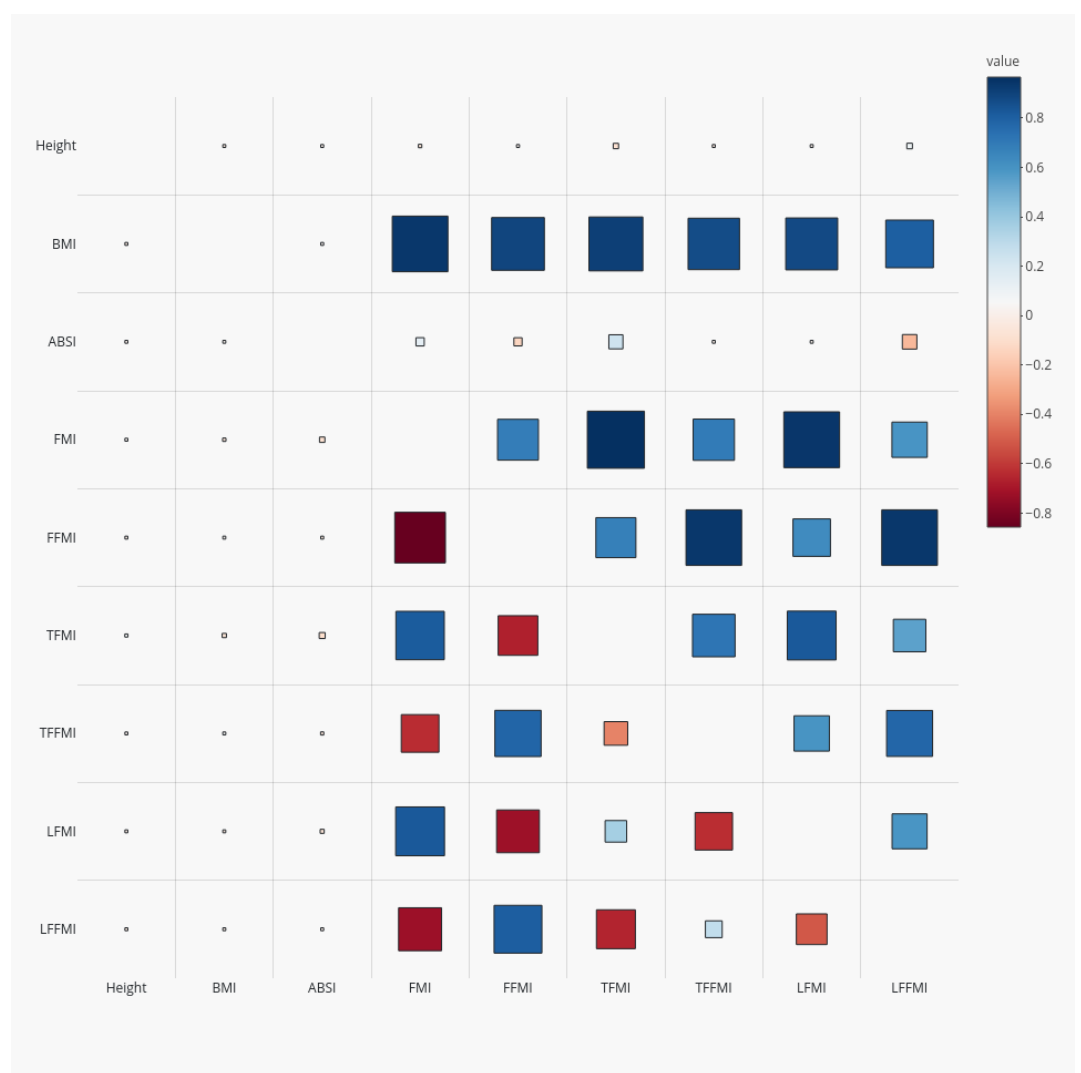
Figure 1. Correlation coefficients for anthropometrics and DEXA-derived body composition indices (Z scores relative to age- and sex-specific means) among NHANES 1999–2006 adults. Red squares denote positive correlations and blue negative ones; larger size indicates larger correlation magnitude. The upper right half of the correlation matrix shows correlations of the unadjusted indices, while for the lower left half, the body composition indices were adjusted to a standard height, weight, and waist circumference using power law scaling. NHANES = National Health and Nutrition Examination Survey; DEXA = dual-energy X-ray absorptiometry; BMI = body mass index; WC = waist circumference; ABSI = a body shape index; FMI = fat mass index; FFMI = fat-free mass index; TFMI = trunk fat mass index; TFFMI = trunk fat-free mass index; LFMI = limb fat mass index; LFFMI = limb fat-free mass